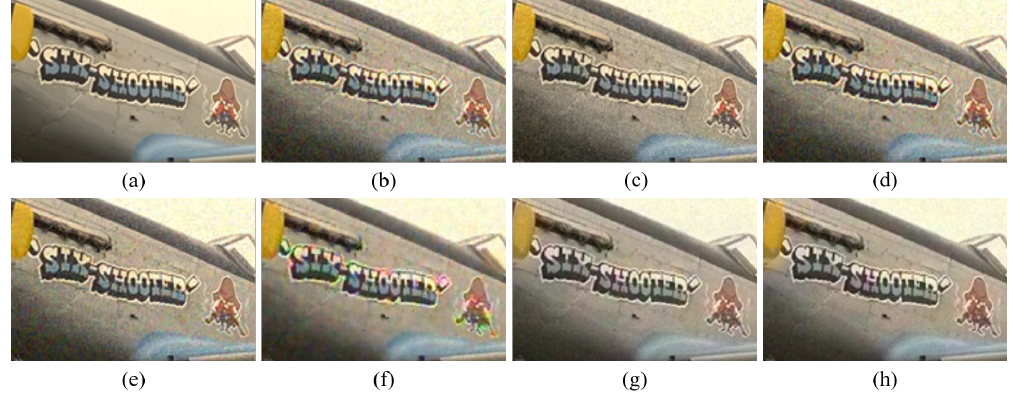
Figure 9. Showing the enlarged regions of Figure 8. ( a ) Original ( b ) ICC [12], ( c ) DNet [13] ( d ) RI [14]